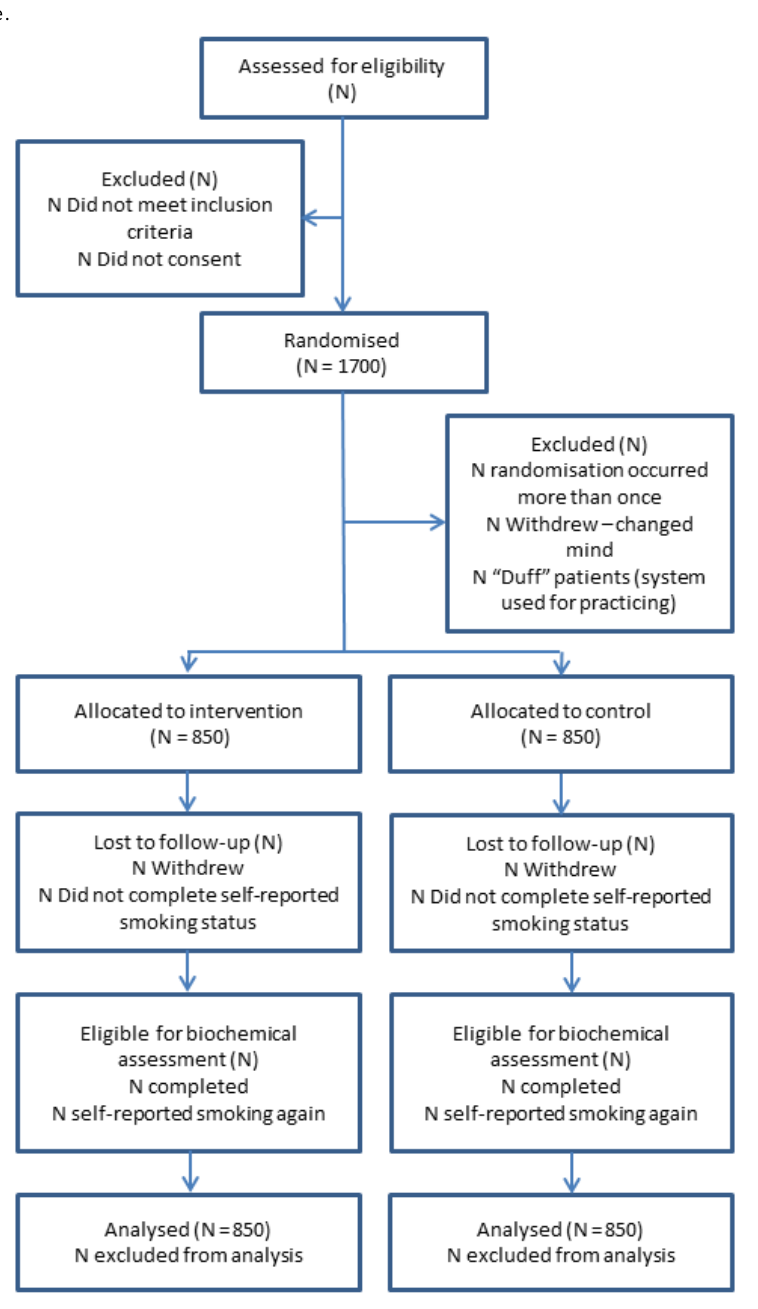
Figure 1. Projected trial